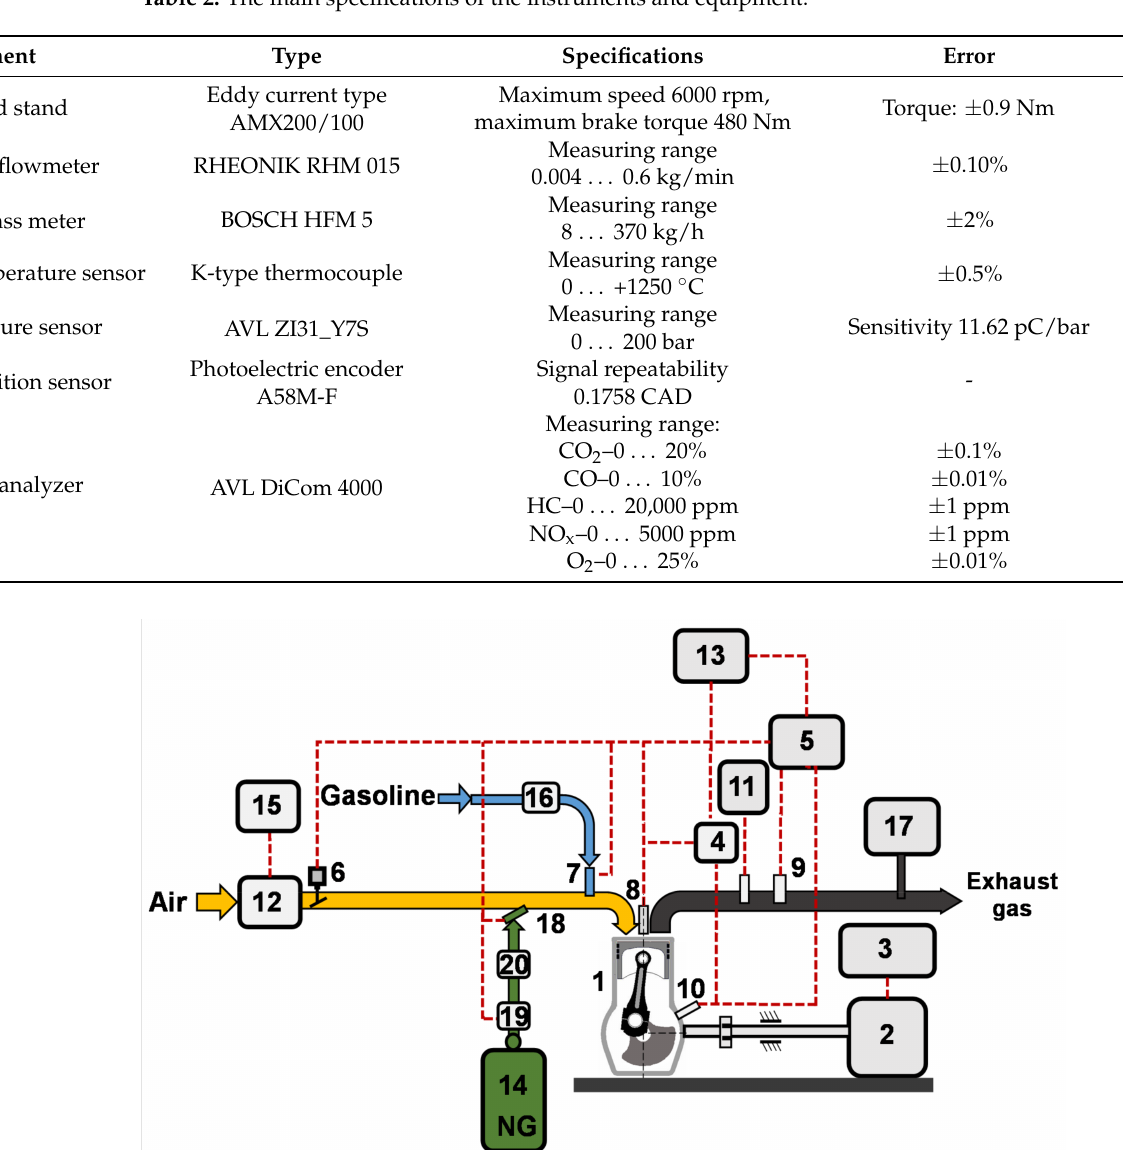
Table 2. The main specifications of the instruments and equipment.